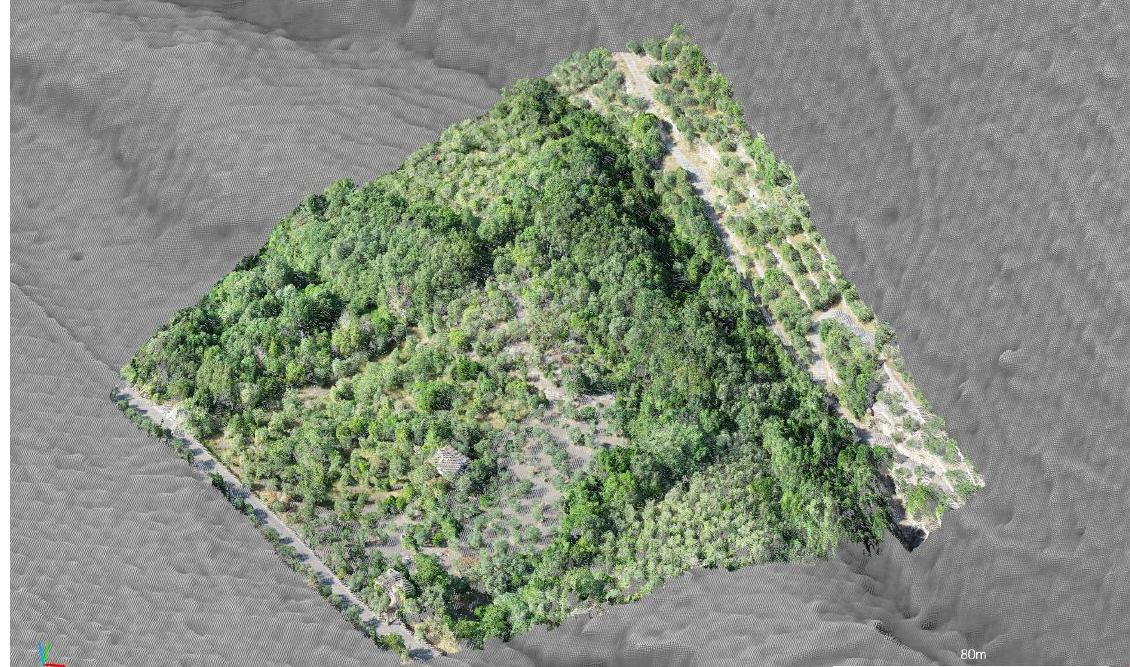
Figure 6 – The High-resolution DSM provided by the drone survey and the low-resolution LiDAR